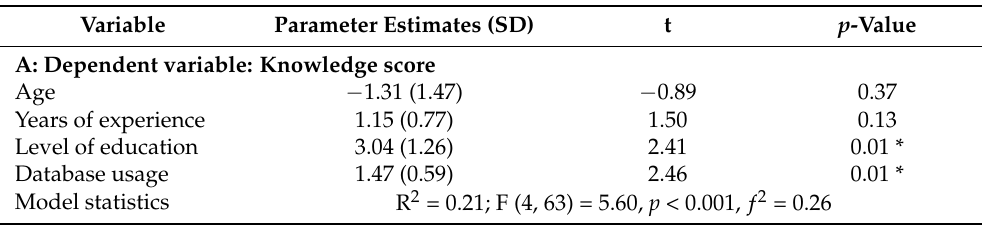
Table 8. Multiple regression models with (A) knowledge, (B) skills and resources, (C) opinion, and (D) barrier scores as dependent